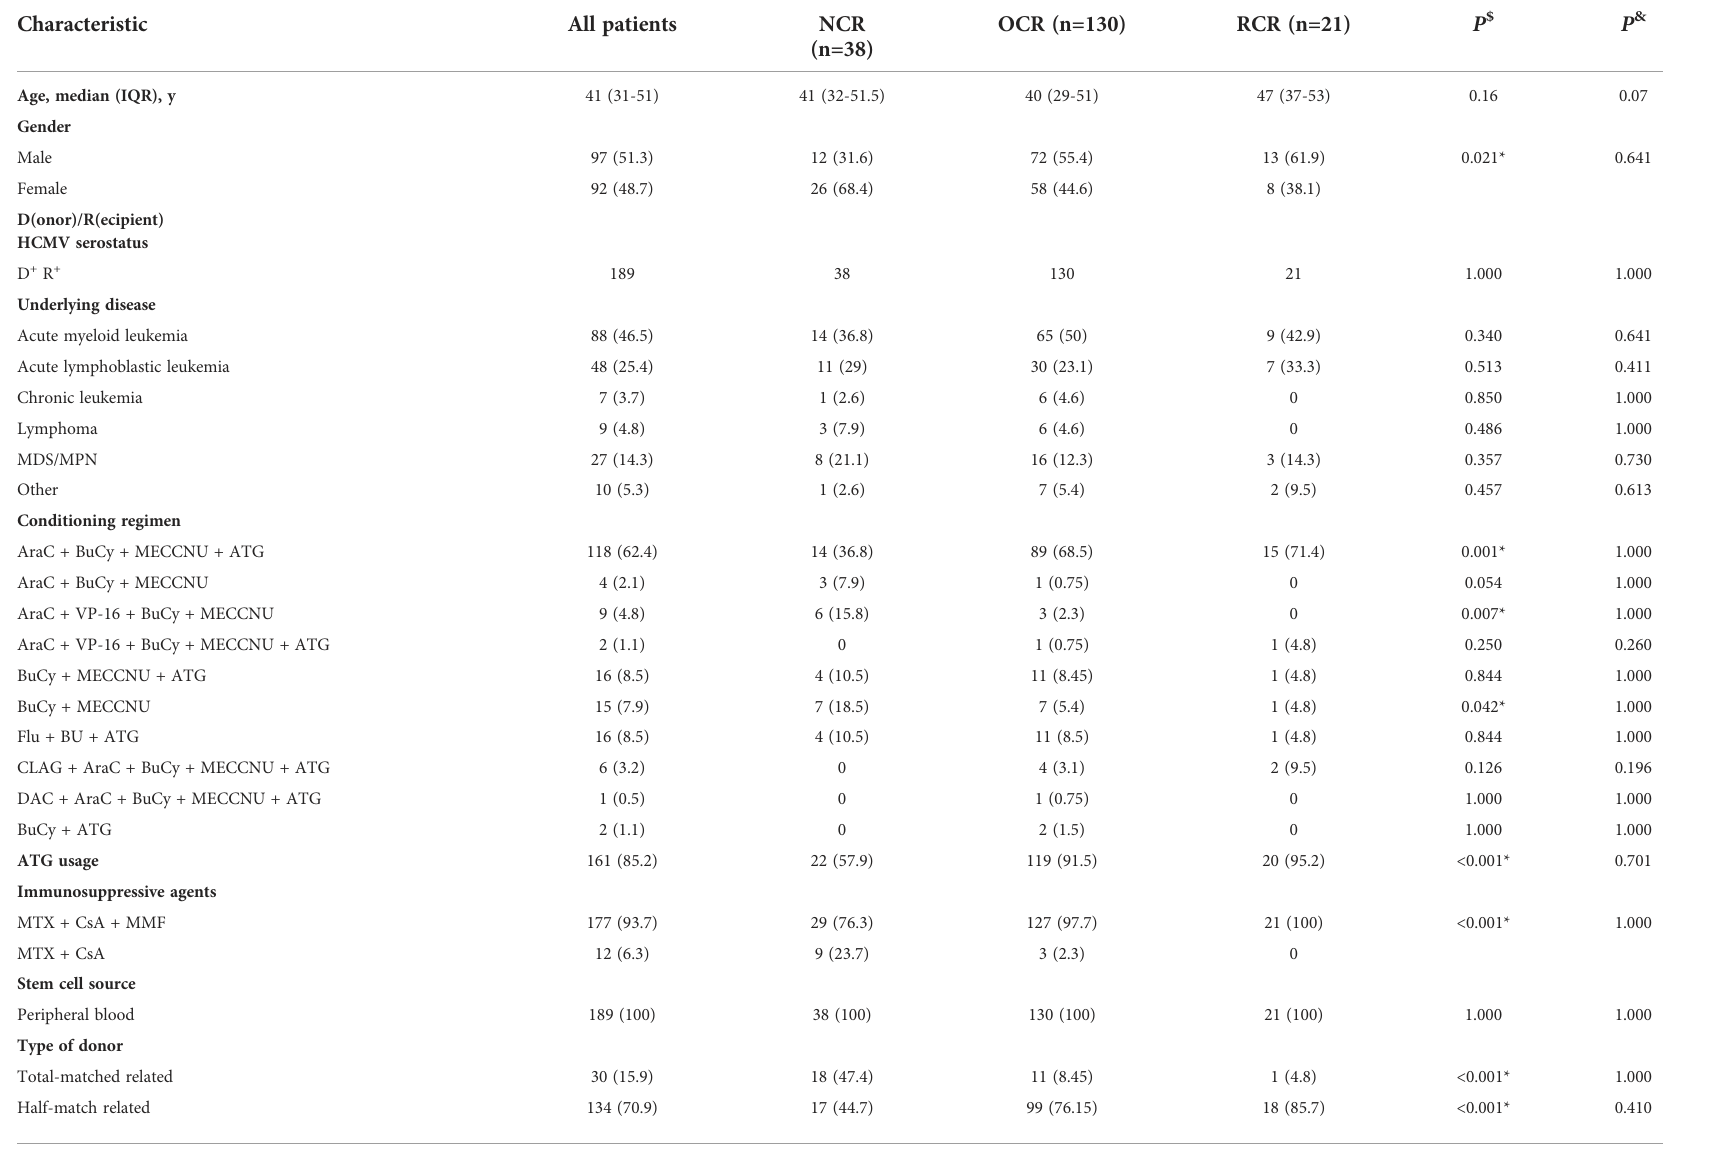
TABLE 1 Patient characteristics and clinical